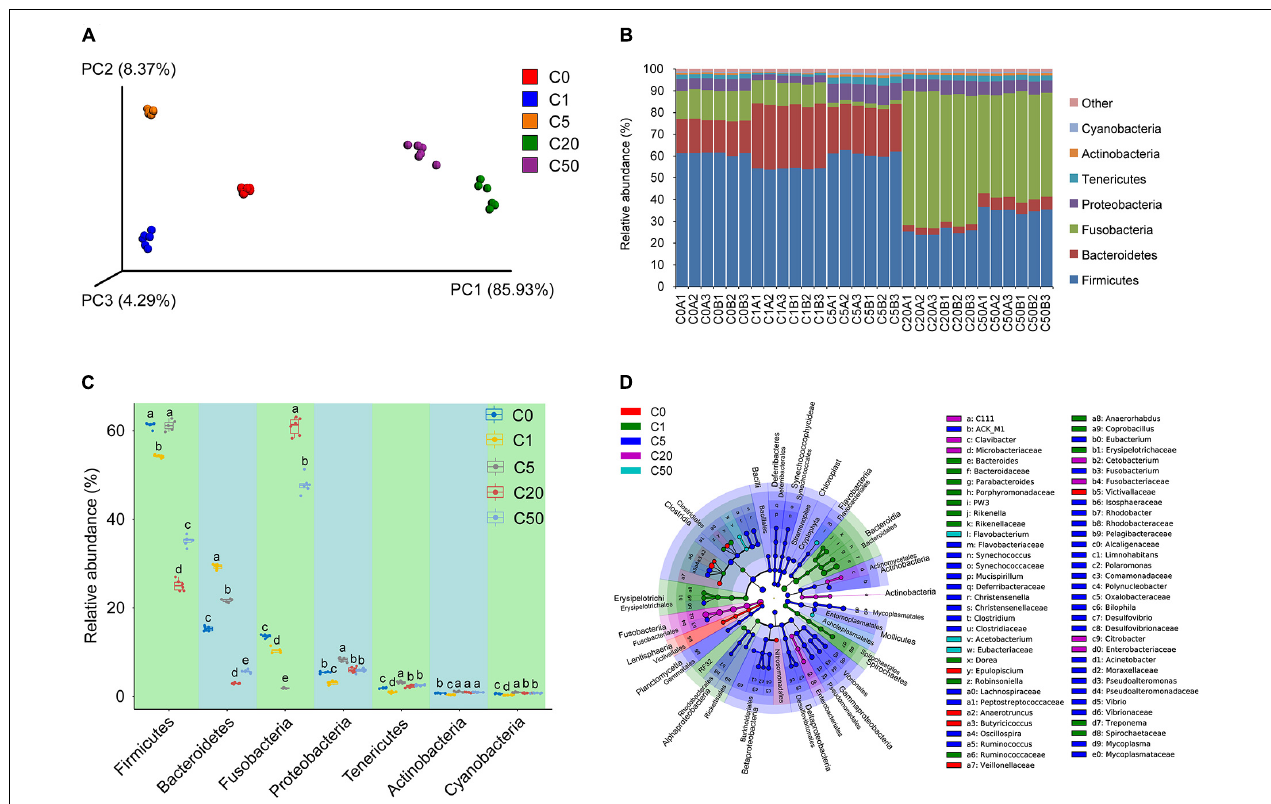
FIGURE 5 | Changes in the gut microbiota composition of Xenopus laevis exposed to different MC-LR concentrations. (A) Principal coordinates analysis profile of the gut microbiota composition. (B) Dominant phyla of the gut microbiota. (C) Significant differences of the dominant phyla of the gut microbiota. (D) Cladogram showed the significantly different taxa of the gut microbiota. Numbers after the letter C in the group names indicate MC-LR concentrations. Different letters above boxes indicate significant differences between the groups ( P < 0.05). TABLE 2 | Changes in alpha-diversity indices of Xenopus laevis gut microbiota exposed to different concentrations of MC-LR. α -diversity index C0